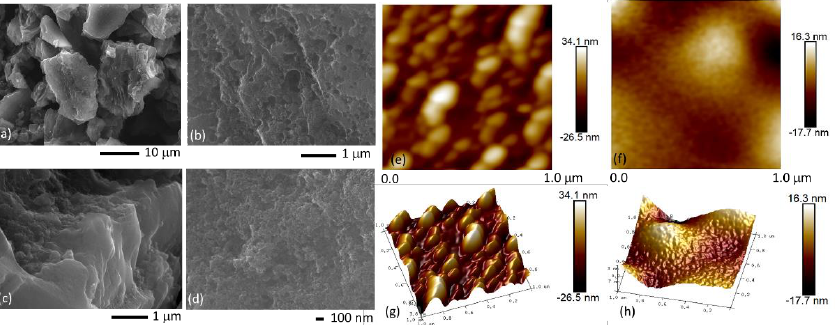
Figure 2. SEM images ( a – d ) and AFM images ( e – h ) of the surface of the AC coating electrode. Nitrogen adsorption/desorption experiments for the ACF fabric yielded a type I iso-